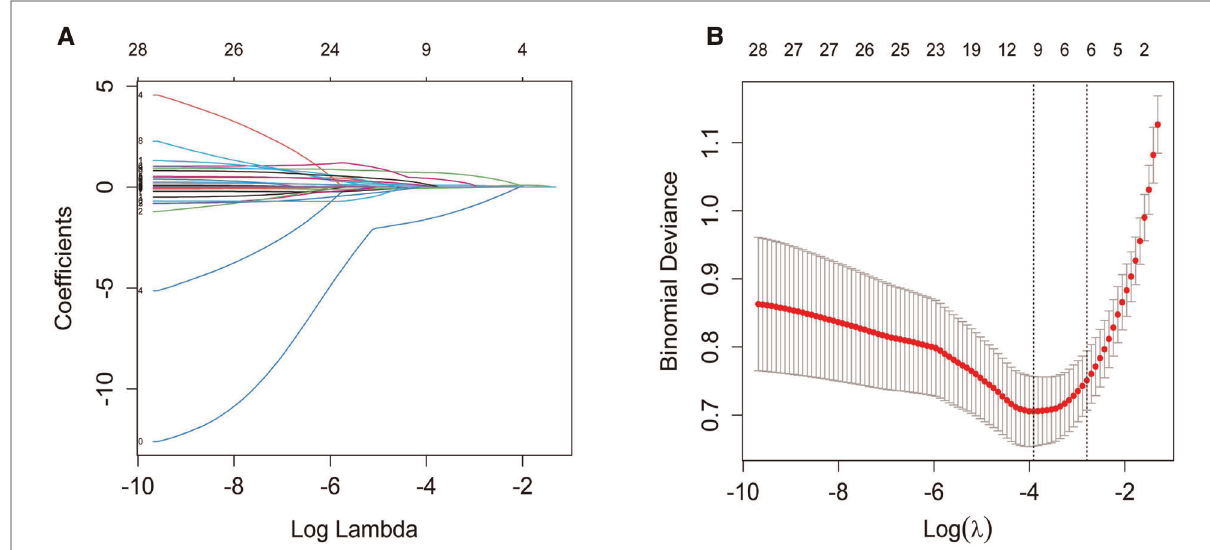
FIGURE 2 Variable selection by the LASSO binary logistic regression model. ( A ) A coef fi cient pro fi le plot was constructed against the log(lambda) sequence. Twenty-eight variables with nonzero coef fi cients were selected by deriving the optimal lambda. ( B ) Following veri fi cation of the optimal lambda in the LASSO model, we plotted the binomial deviance curve versus log(lambda) and drew dotted vertical lines based on 1 standard error criteria. LASSO, Least absolute shrinkage and selection operator.